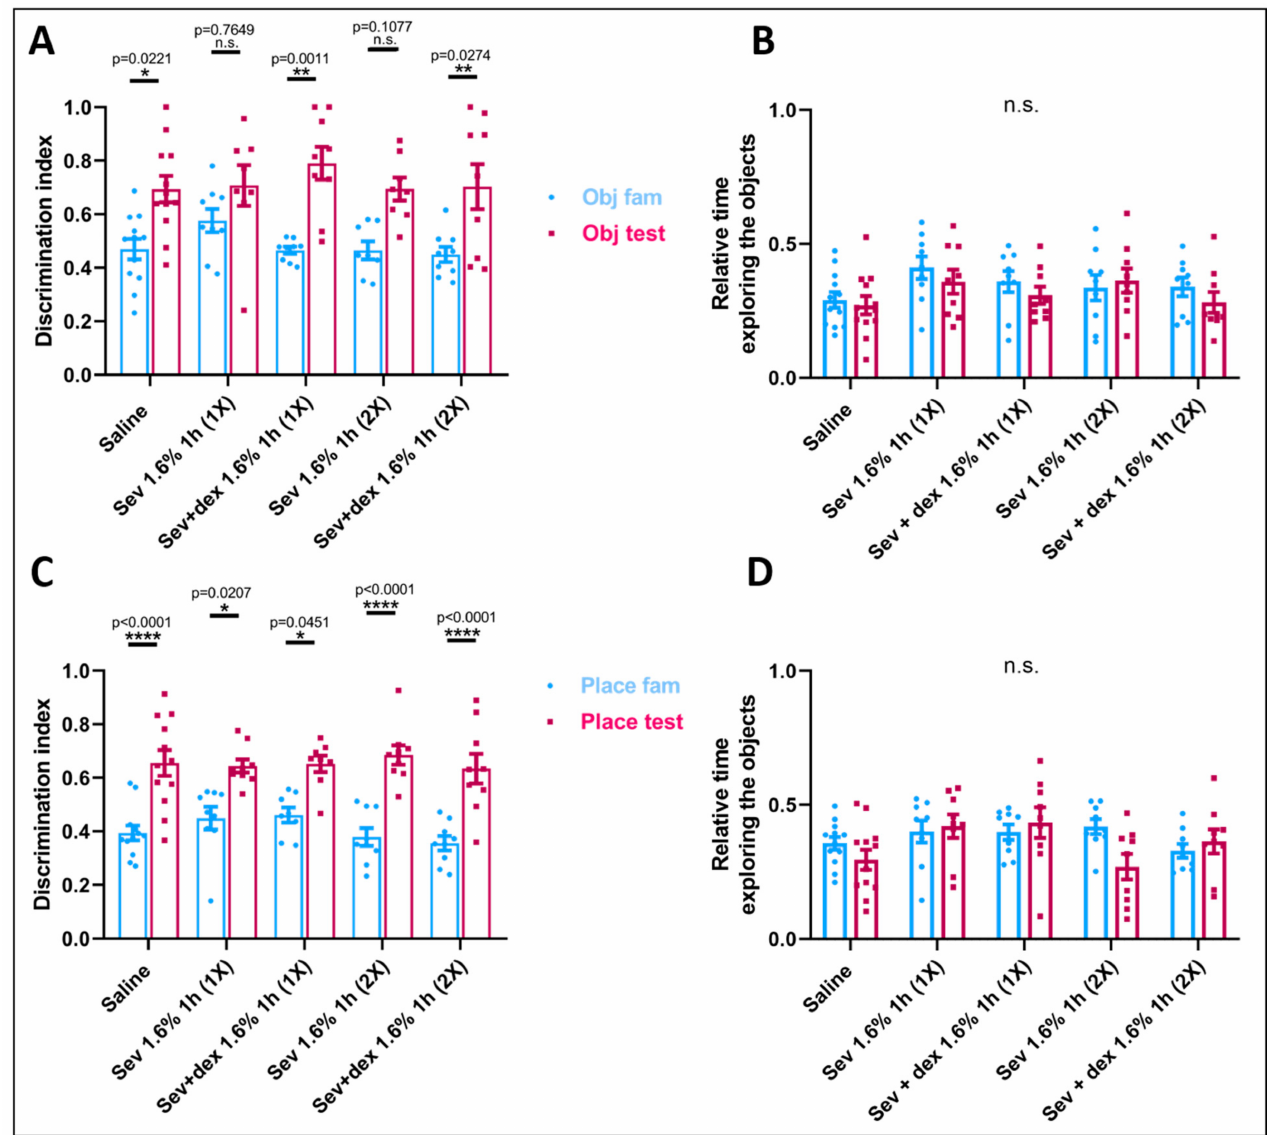
Figure 4. Pre-treatment with subcutaneous DEX was able to prevent recognition memory deficits. ( A ) Discrimination index calculated as the time spent with the novel object (TN) divided by the total time spent with both objects (TN + TF) and ( B ) relative time interacting with both objects (TN+TF)/(duration of the phase). ( C ) Discrimination index calculated as the time spent with the object located in a different place (TN) divided by the total time spent with both objects (TN + TF) and ( D ) relative time interacting with both objects (TN + TF)/(duration of the phase). Bars indicate mean ± SEM ( A ) F (4,85) = 0.4862, ** p = 0.0011, ** p = 0.0274, and * p = 0.0221, ( B ) F (4,94) = 0.7172, p = 0.5823 ( C ) F (4,86) = 1.253, **** p < 0.0001, ( D ) and F (4,94) = 1.867, p = 0.1226 using two-way ANOVA with Tukey’s post hoc analysis for multiple comparisons. n = 12 and n = 9 for control and experimental groups, respectively. (n.s. = not